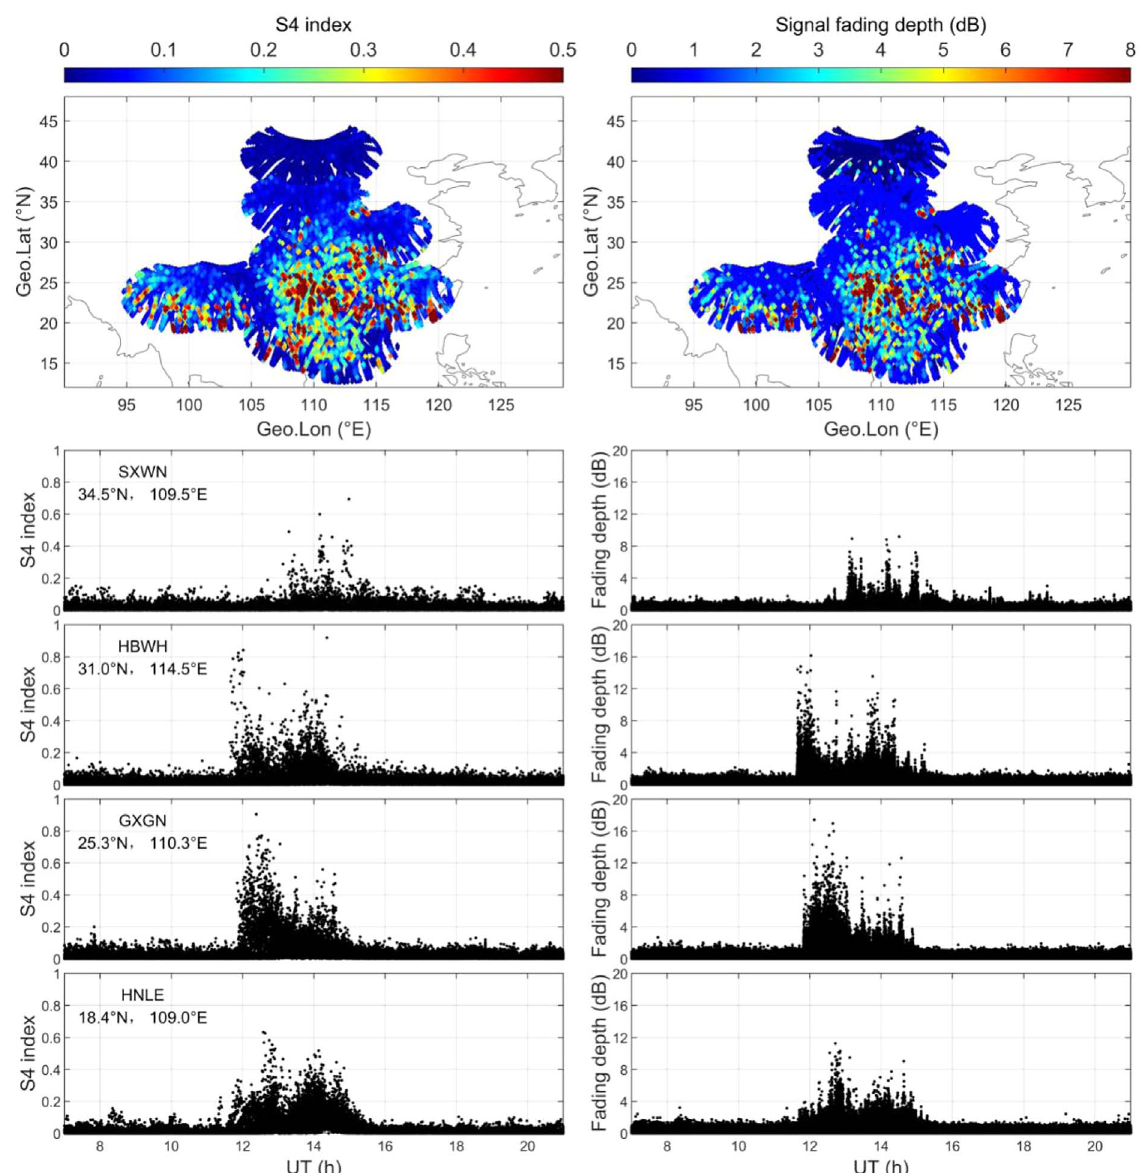
Fig. 1. The S 4 index (left panels) and signal fading depth (right panels) projected on geographic maps (top panels, using data during 10:30 – 18:00 UT) and at selected sites (bottom panels) on 15 January